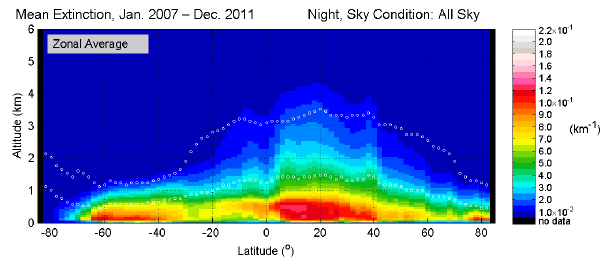
Fig. 7. Ratio of daytime to nighttime zonal mean aerosol extinction: JJA, 2006–2011.